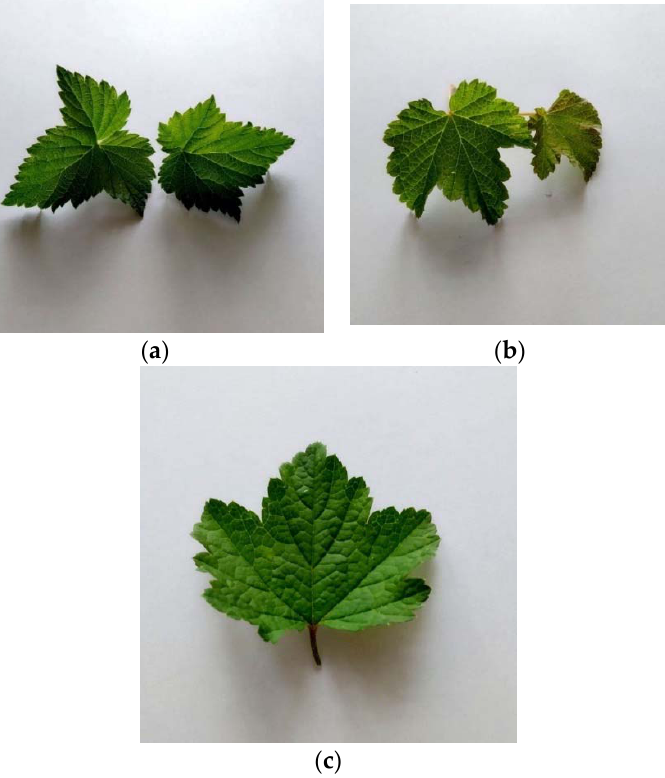
Figure 1. Leaves of black ( a ), red ( b ) and white currant ( c ) shrubs [own sources].